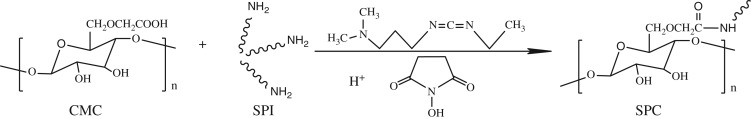
Mechanism of SPC synthesis.